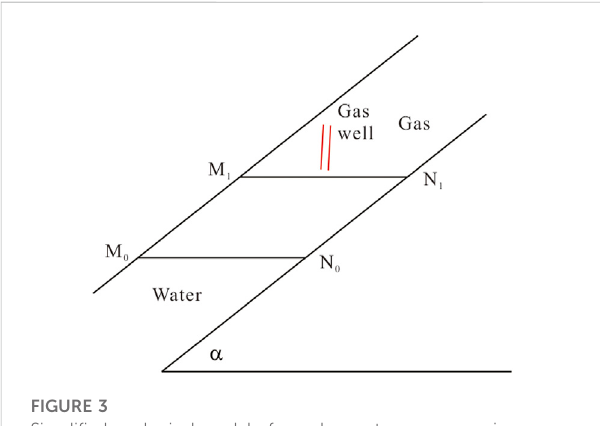
FIGURE 1 Starting pressure of typical deep tight gas reservoirs in western Sichuan under different water saturation conditions.